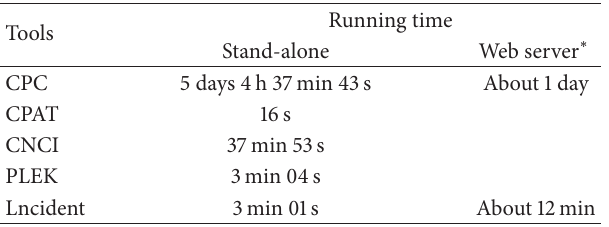
Table 4: Running time on human dataset.